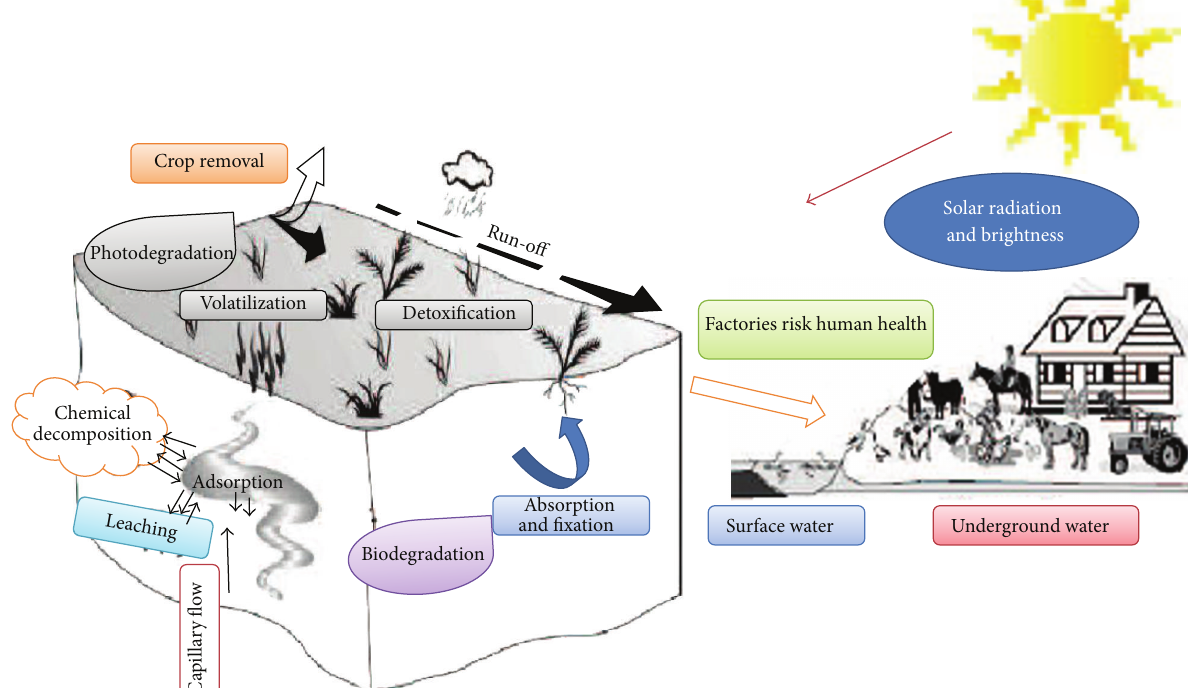
Figure 1: Pesticides contaminant and biodegradation in environment [11,